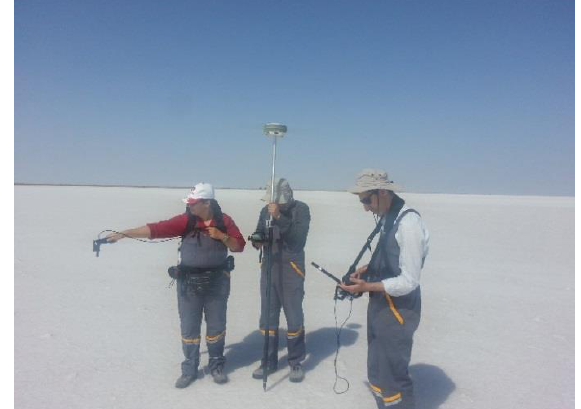
Figure 1. Surface reflectance measurements